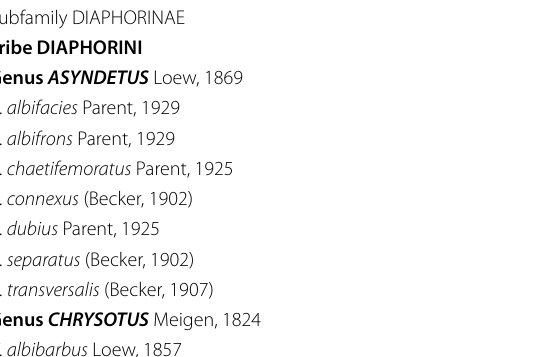
Table 1 List of dolichopodid taxa recorded from